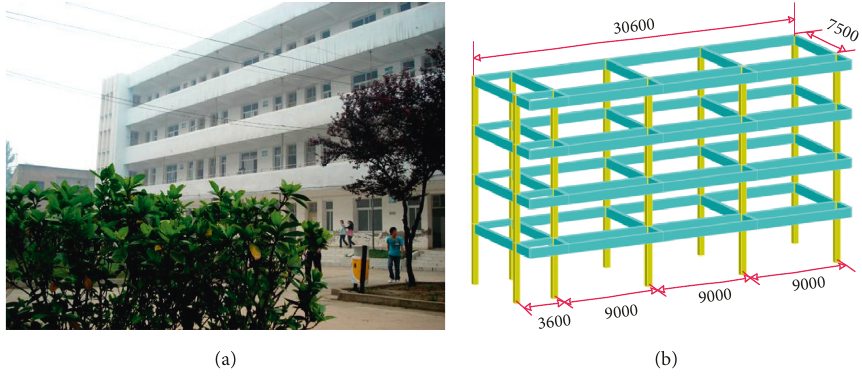
Figure 1: Span dimensions and number of storeys of a typical school